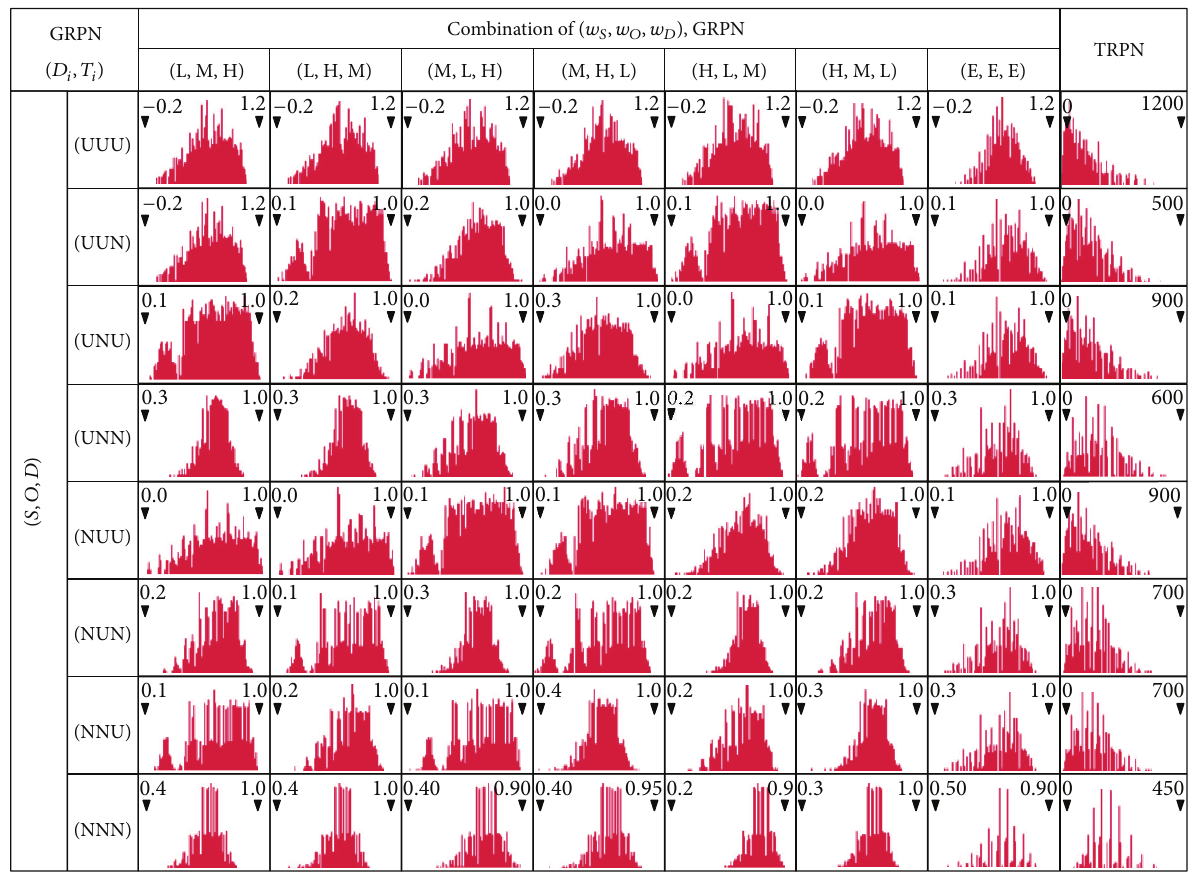
Figure 2: Comparison of correlation coefficients for the risk